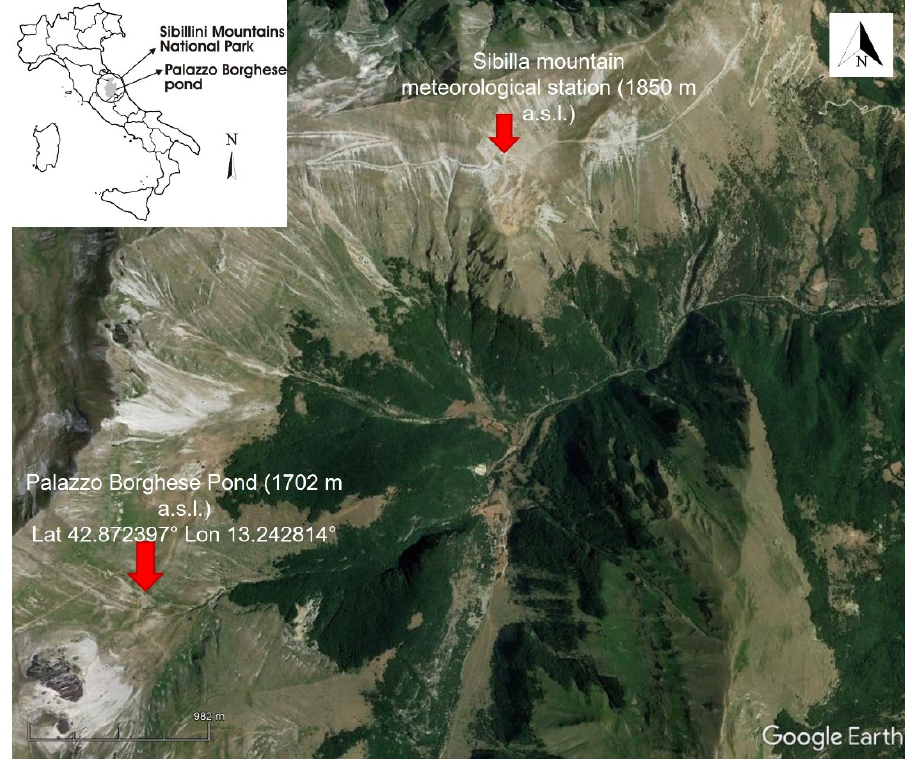
Figure 1. Study area and location of the meteorological station on Sibilla Mountain. © 2022 Google.